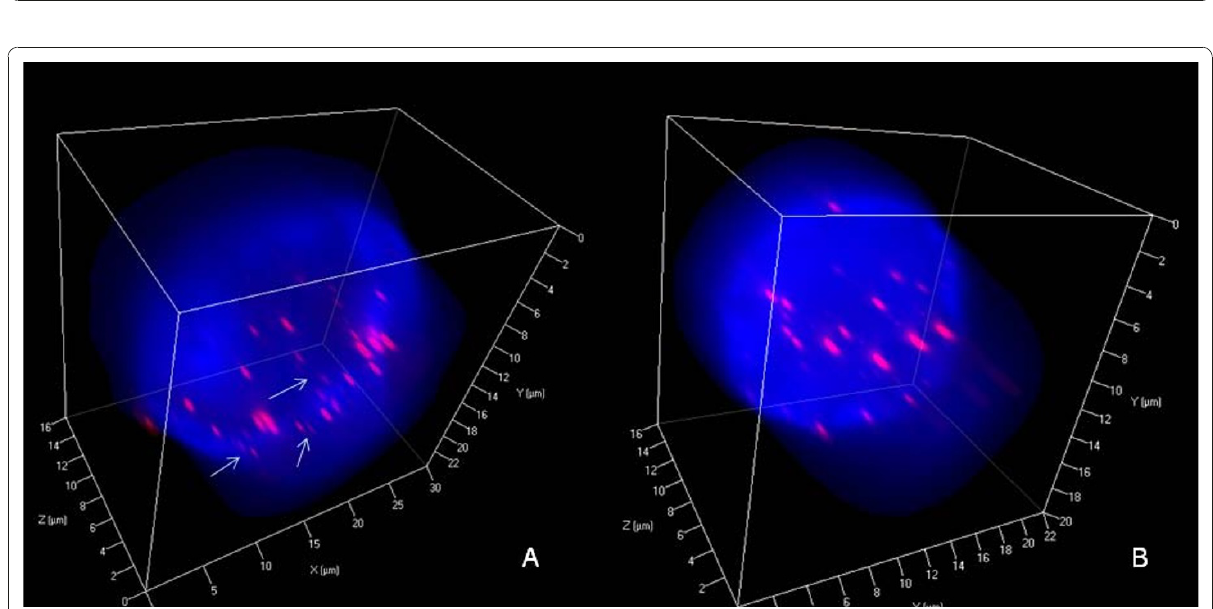
Figure 3 High apoptosis rate but low STAT5A expression in U-HO1-PTPN1 . A. Apoptotic cells (M2), on the left to the G1 peak on the x-axis, are about 4 times more frequent in U-HO1-PTPN1. B. Abundant phosphorylated STAT5A is present in the cytoplasm of U-HO1 mononuclear H- and multinuclear RS-cells (left panel) but is barely present in U-HO1-PTPN1 (right panel). Note numerous bi- or multinucleated RS-cells in U-HO1- PTPN1 but not in U-HO1.